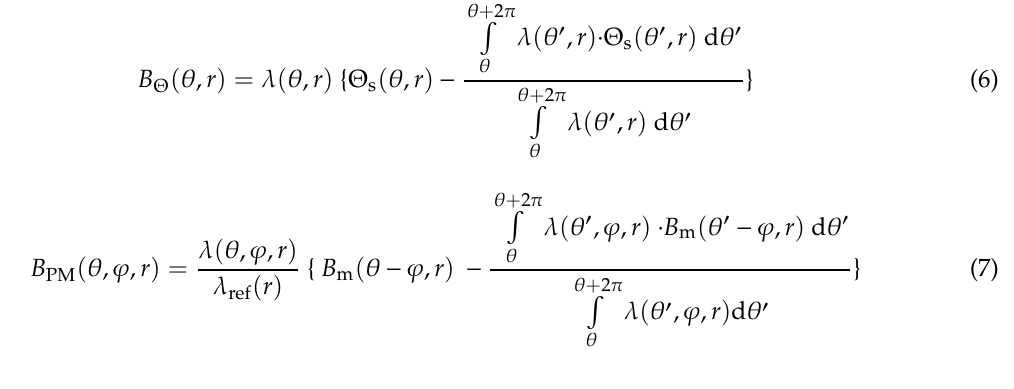
Figure 9. Equivalent function of the magnetic field force lines length in permanent magnets. By defining the winding magnetomotive force (MMF) function as: where ),( ra s —stator ampere-turns, the axial components of flux-density can be defined as follows: